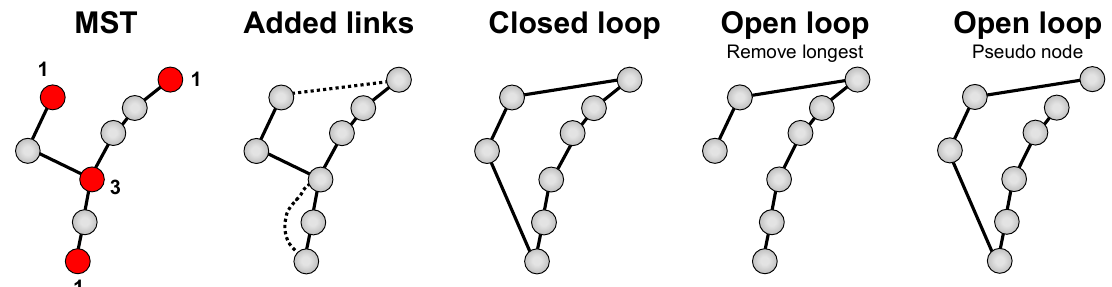
Figure 6. Christofides operates by adding links so that Euler tour can be achieved. However, the quality of the result depends on the order in which the links are travelled. In this case, it achieves optimal choice for closed loop solution but not for the open loop case.